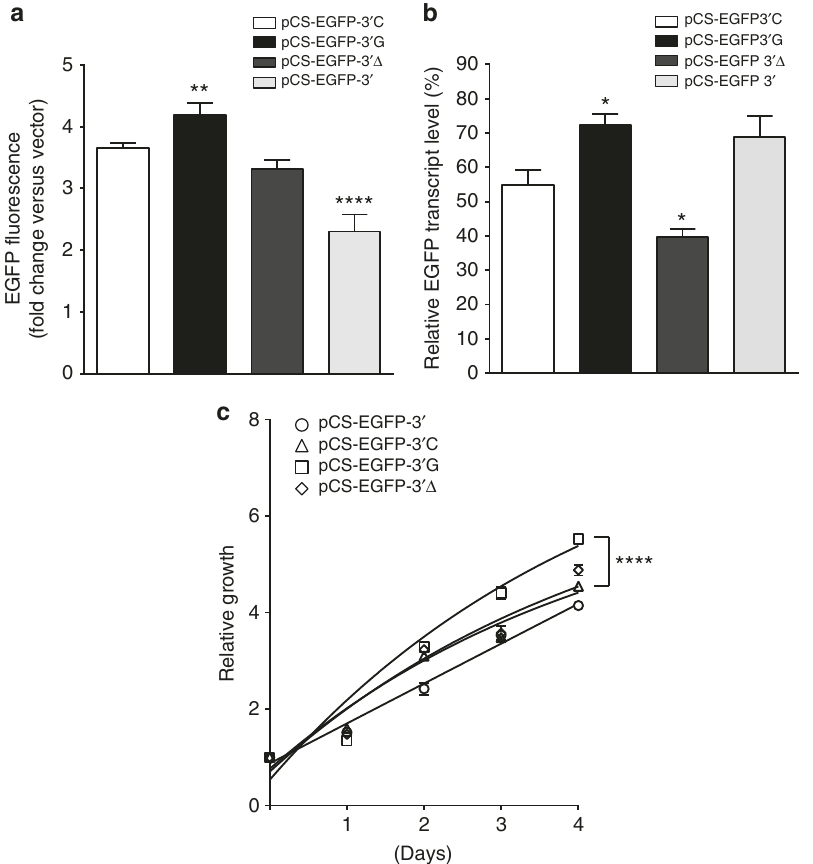
Fig. 3 The rs116446171 variants affect reporter activity and cell proliferation. a EGFP reporter activity in HEK293T stably transduced cell lines. Cells transduced with the risk variant (G) showed signi fi cantly increased fl uorescence levels of EGFP compared to the cell lines transduced with the wild type (WT, (C); P = 0.012). Cells transduced with the Null ( Δ ) had decreased EGFP fl uorescence ( P = 0.054, n = 14), and cells transduced with the commercial 3 ′ UTR of EXOC2 showed signi fi cantly decreased EGFP fl uorescence ( P < 0.0001, n = 14). Data are expressed as mean fold change relative to the cells transduced with the vector, ±standard error of the mean (s.e.m.), n = 14 replicates. ** P < 0.01, **** P < 0.0001. b Quantitative PCR analysis of